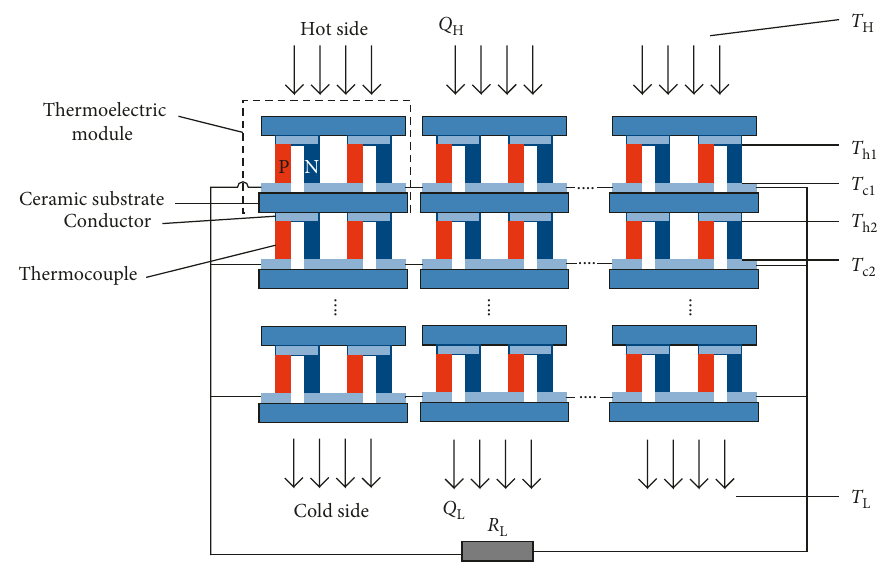
Figure 2: Schematic layout of thermoelectric